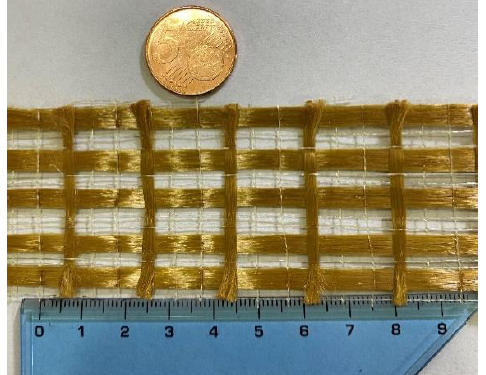
Figure 1. Structure of polybenzoxole (PBO) mesh used in the present research.